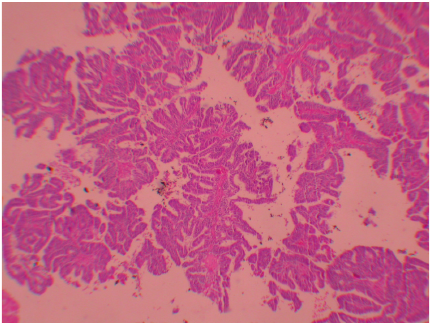
Figure 2: Appearance of the papillae in villoglandular papillary ade- nocarcinoma of the uterine cervix immunohistochemical staining (IH).